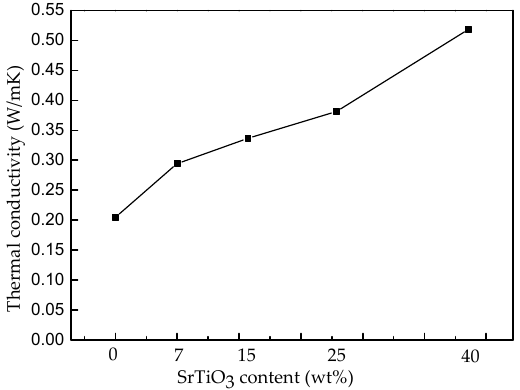
Figure 6. Thermal conductivity of SrTiO 3 /epoxy composites with different weight fractions at 25 °C.